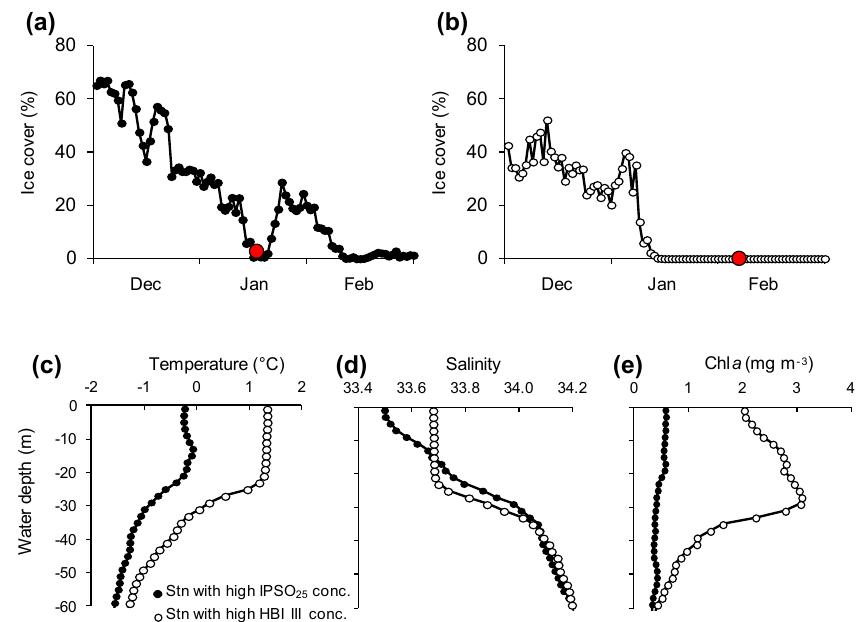
Figure 5. Oceanographic differences between stations with high IPSO 25 vs. high HBI III concentrations in suspended matter. (a) Timeline of sea ice cover at stations with high IPSO 25 concentrations (mean of stations 18, 19, 20, 31). The red dot indicates the time of sampling. (b) Timeline of sea ice cover at stations with high HBI III concentrations (mean of stations 45, 50, 51, 52). (c) Vertical profiles of temperature, (d) salinity and (e) chlorophyll a . Table 2. Euphausia superba : concentrations of IPSO 25 and HBI III in different body fractions. Average stomach values are used as baseline for comparisons across body fractions, “Ratio (stomach /X )”. X is the digestive gland, gut, muscle, rest or whole krill. The I / (I + H) ratio was calculated as the ratio of means for those stations where both IPSO 25 and HBI III had been detected in at least one of the body fractions. r is the